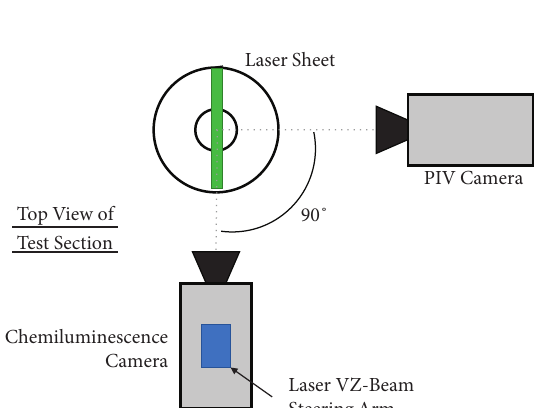
Figure 4: Schematic of the optical diagnostic layout around the combustion